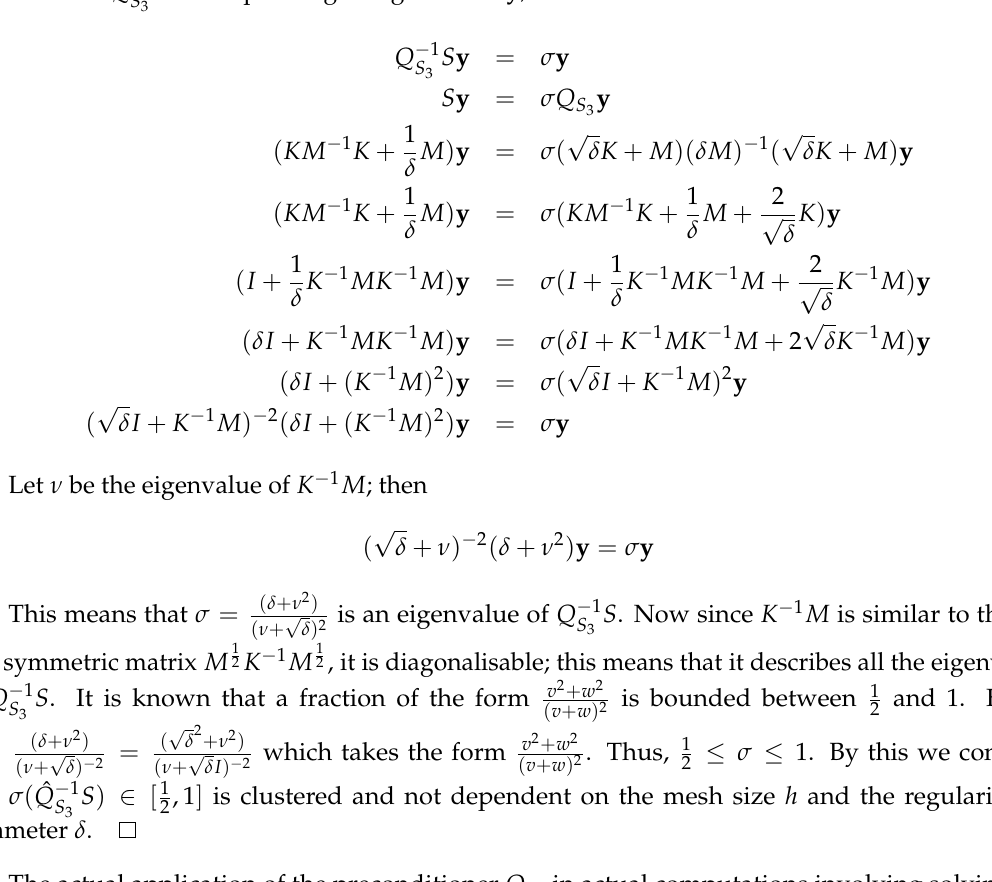
Algorithm 1. Application of Preconditioner Q S